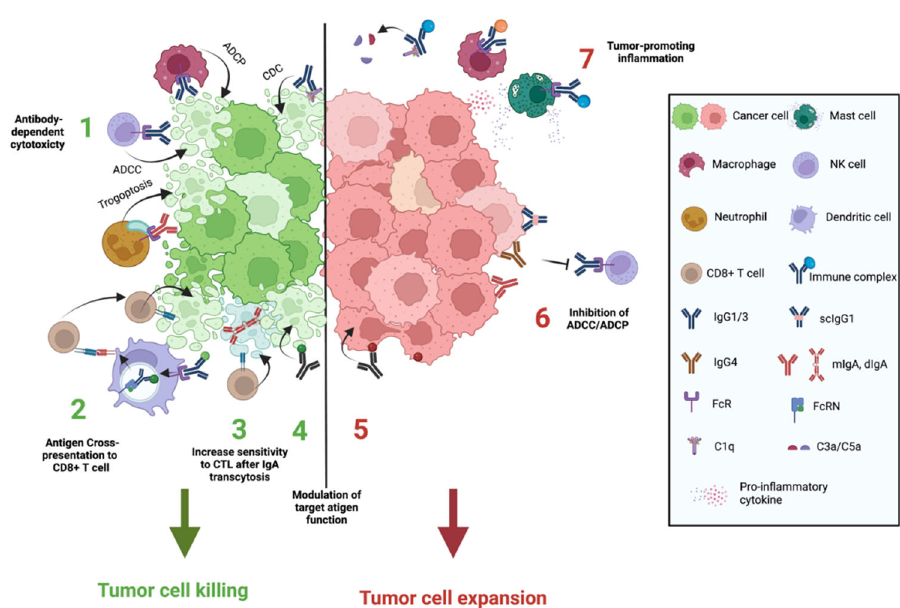
Figure 2. Mechanisms of action of antibodies in cancer. Antibodies can use several mechanisms to suppress (1–4) or promote (5–7) tumor growth. (1) Certain subclasses of antibodies can mediate tumor cell killing by ADCC mediated by NK cells, ADCP by macrophages, trogoptosis by neutrophils, and CDC. (2) Capture of antibody/antigen complex by DC can prime anti-tumor immunity through antigen cross-presentation to CD8+ T cells. (3) Transcytosis of dimeric IgA in tumor cells increases their sensitivity to CD8+ T cell-mediated cytotoxicity. (4) Direct modulation of target antigen func- tion leading to tumor cell dysfunction/elimination. (5) Modulation of tumor antigens leading to survival/proliferation of tumor cells. (6) IgG4, scIgG1, and IgA can suppress the effector functions of cytotoxic antibody isotypes. IgG4 compete with IgG1 for Fc γ R binding. ScIgG1 has a reduced ability to induce ADCC compared to IgG1. IgA inhibits NK-dependent ADCC mediated by IgG1/IgG3. (7) IgG-antigen immune complexes can induce tumor-promoting inflammation by stimulation of macrophages and mast cells and/or by the activation of the classical complement pathway and the release of pro-inflammatory